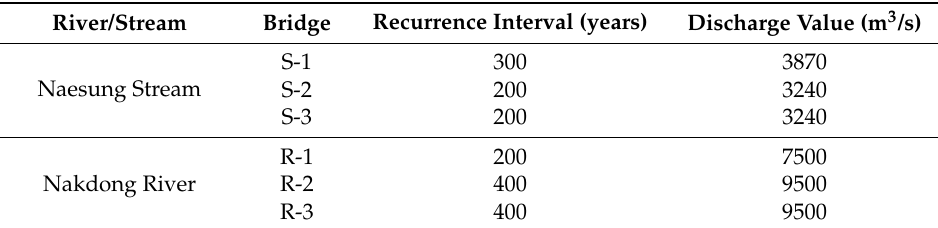
Table 1. Recurrence interval and discharge values to inundate each